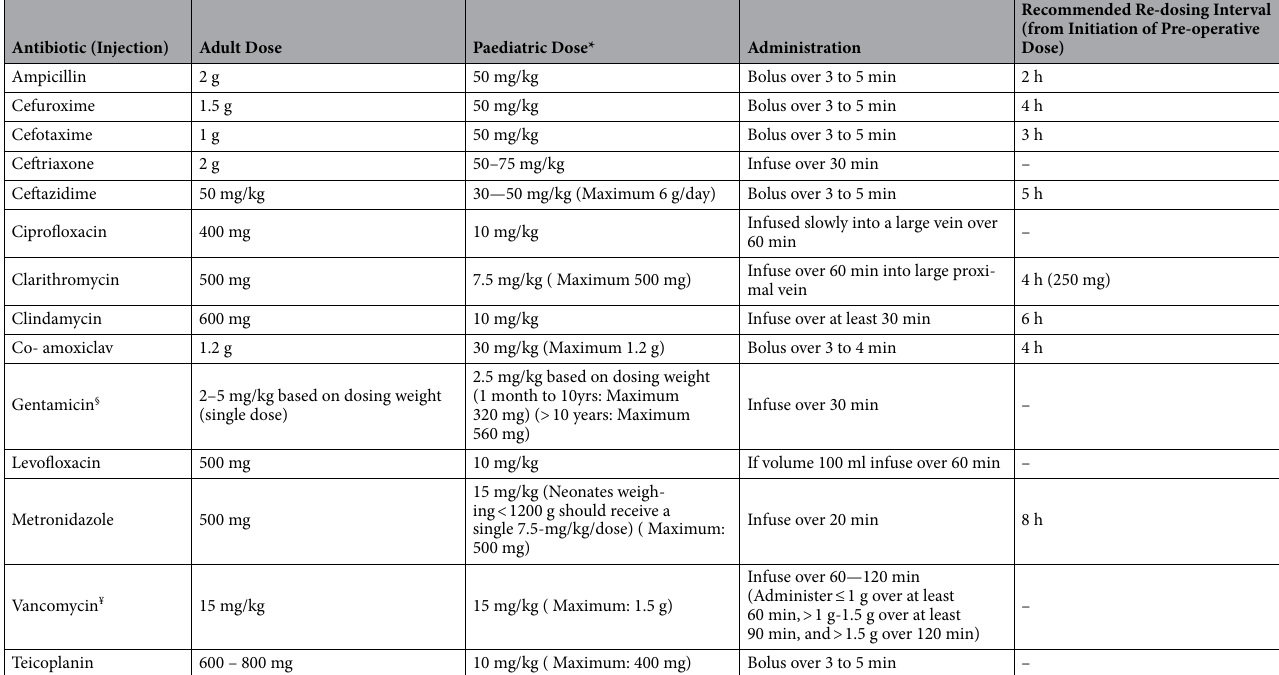
Table 2. Recommended dose, administration and re-dosing interval of intravenous surgical prophylaxis antibiotics. *The Maximum pediatric dose should not exceed the usual adult dose. § Dosing is based on the patient’s actual body weight. If the patient’s actual weight is more than 20% above ideal body weight (IBW), the dosing weight (DW) can be determined as follows: DW = IBW + 0.4 (actual weight − IBW). Ideal Body Weight (IBW) = 45.4 + [0.89 x (height {cm} − 152.4)] (+ 4.5 if male). ¥ Vancomycin dose should be based on total body weight, rounded to the nearest 250 mg up to a maximum 2